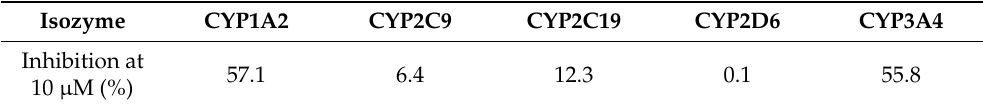
Figure 8. Effects of hybrid A8 on the expression of GPX4 in MCF-7 cells; cells were treated with 0, 2.5, 5 and 10 μ M of compound A8 for 48 h, and GAPDH was used as the internal control. Table 2. Cytochrome P450 inhibition of hybrid A8